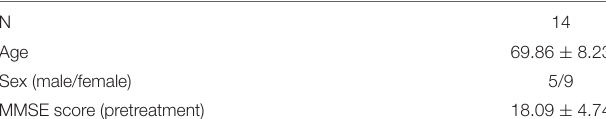
TABLE 2 | Baseline demographic characteristics of the